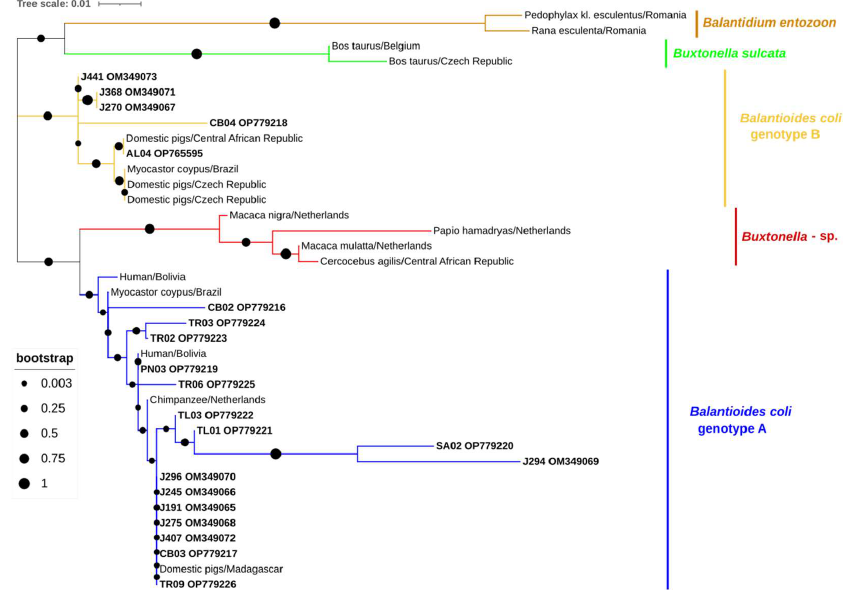
Figure 3. Phylogenetic analysis of Balantioides coli found in wild boars. Tree inferred using the MEGA X maximum likelihood method (Tamura 3-parameter model) and the Interactive Tree of Life (iTOL) based on 38 nucleotide Balantioides coli sequences at the ITS marker, including sequences found in this study ( Balantioides coli genotypes A and B, plus its accession numbers, is in bold) and 17 strains of different genotypes obtained from GenBank (no bold or shading and identified with the accession number, host and country of origin). Blastocystis sp. was identified in 42 samples (29.2%, 95% CI: 21.9–37.2). BLAST analysis indicated that six sequences shared 99.8–100% identity with a Blastocystis sp.